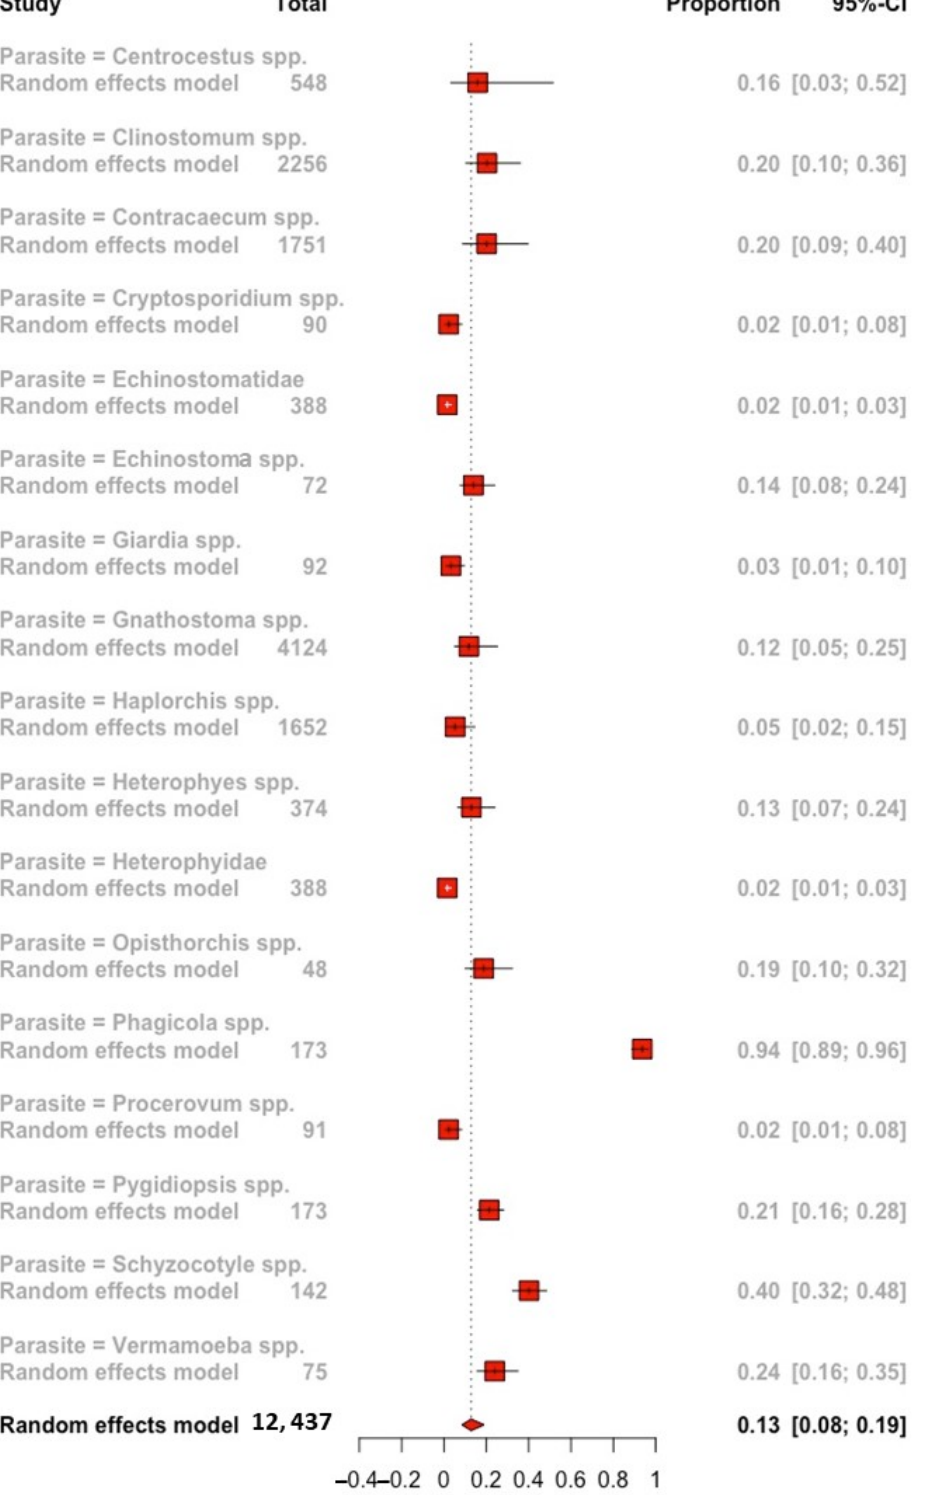
Figure 4. Forest plot of the global prevalence of parasitic infections with zoonotic potential in tilapia according to parasitic genera and family according to the available information.